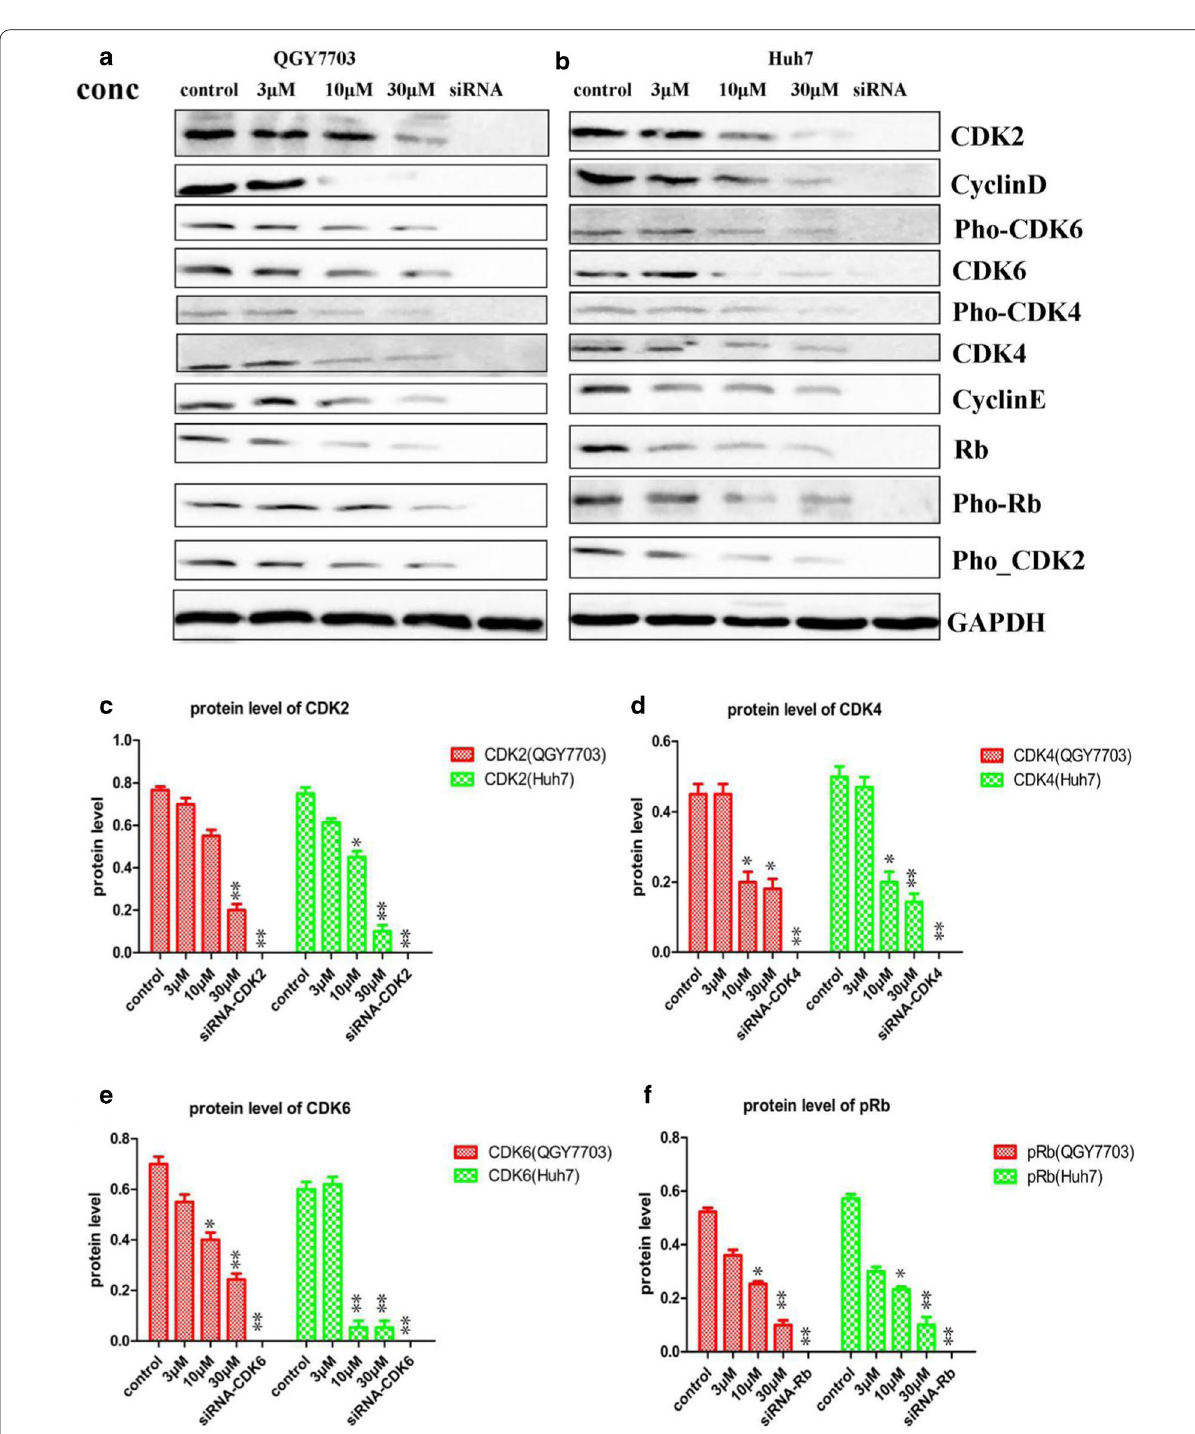
Fig. 4 Effects of Vanoxerine dihydrochloride treatment on the expressions of proteins that play key roles in cell cycle progressions. a QHY7703 and b Huh7 cells were plated at 6‑well plates with 0.125% FBS medium for 24 h and then with 10% FBS medium containing various concentrations (3, 10, 30 μM) of vanoxerine dihydrochloride. Cells were harvested after 6 h incubation and proteins analyzed by Western blotting. Western blotting results showed that vanoxerine dihydrochloride treatment significantly reduced the expressions of CDK2/4/6, Rb, pho‑CDK2/4/6, pho‑Rb and cyclin D/E in QGY7703 and Huh7 cells. As positive controls, three siRNAs targeting each of the CDK2/4/6 were designed as described previously (Shi et al. 2018), and used to inhibit the expressions of each of the CDK2/4/6proteins. *p < 0.05, significantly different from the control PBS treatment